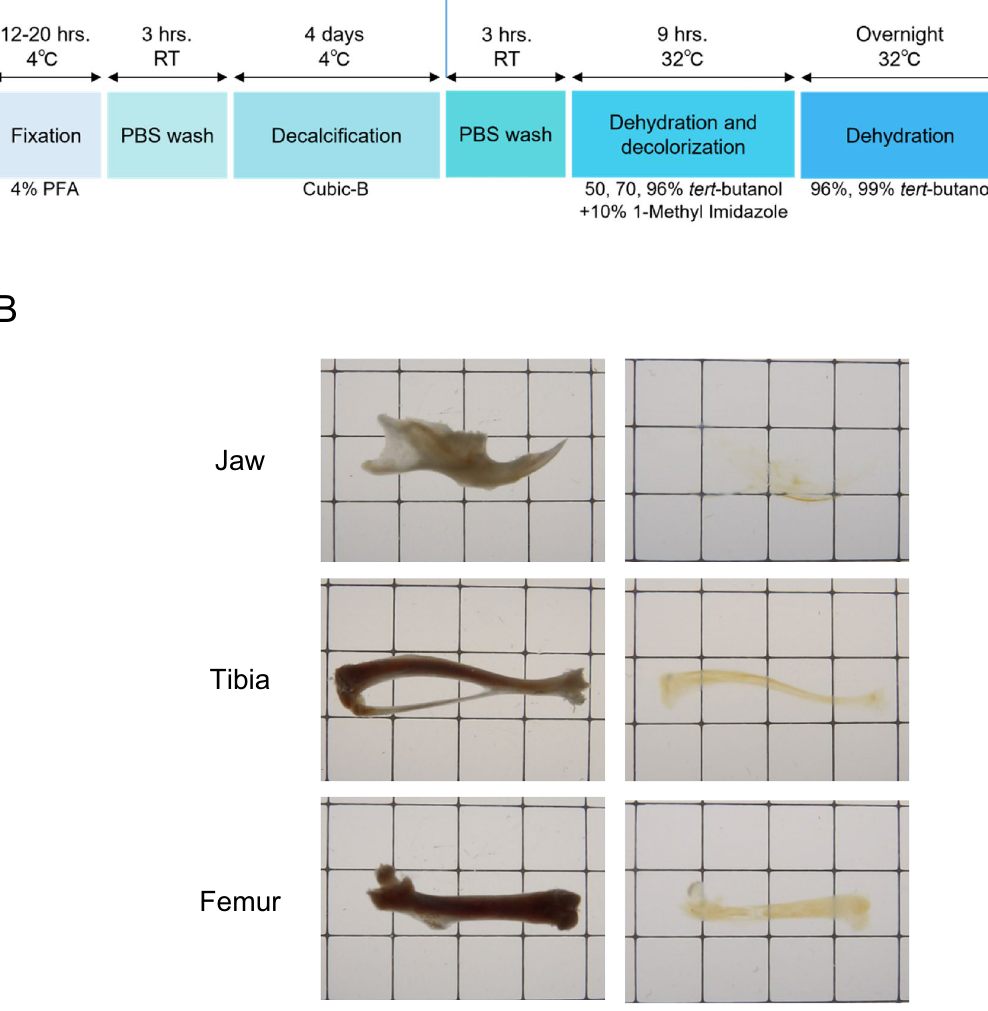
Figure 1. Establishment of a novel optical clearing method for murine bones (Osteo-DISCO). ( A ) Brief description of the new clearing procedure. ( B ) Murine bones (jaw, tibia, and femur) cleared using our procedure. Each image on the left side was captured before clearing, and images on the right side were captured after clearing. All bright field images were captured with bones immersed in silicone oil and on a 5 mm square of graph